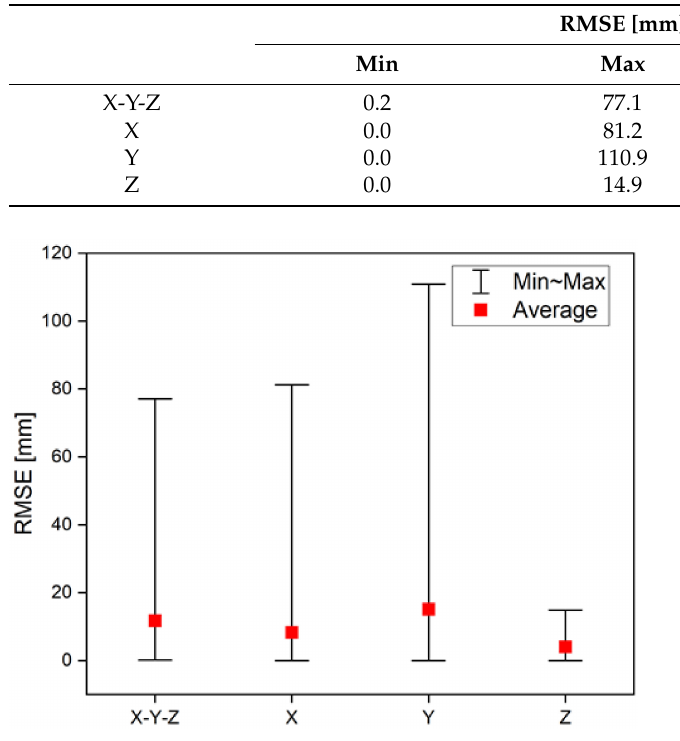
Table 3. RMSE of the X-Y-Z estimation position.